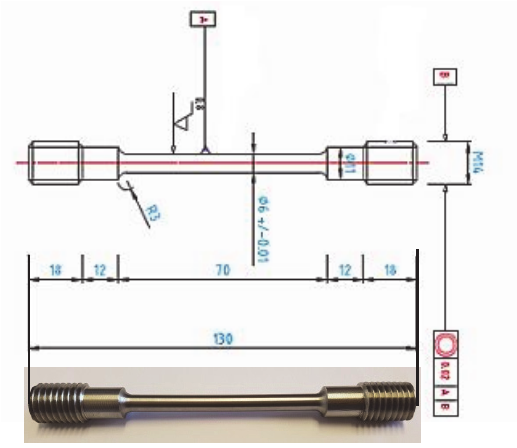
Figure 1: Creep specimen dimensions.